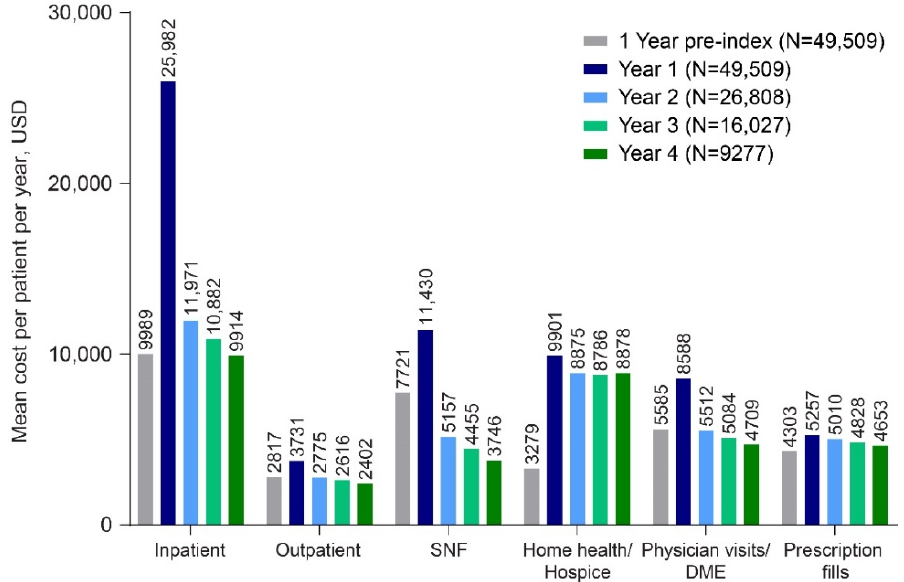
Figure 1. Annualized unweighted all ‐ cause costs per patient per year by type of Medicare setting adjusted to 2015 USD. LTC and Medicare costs may not sum to total row costs due to rounding. Abbreviations: DME = durable medical equipment; LTC = long ‐ term care; SNF = skilled nursing facility.